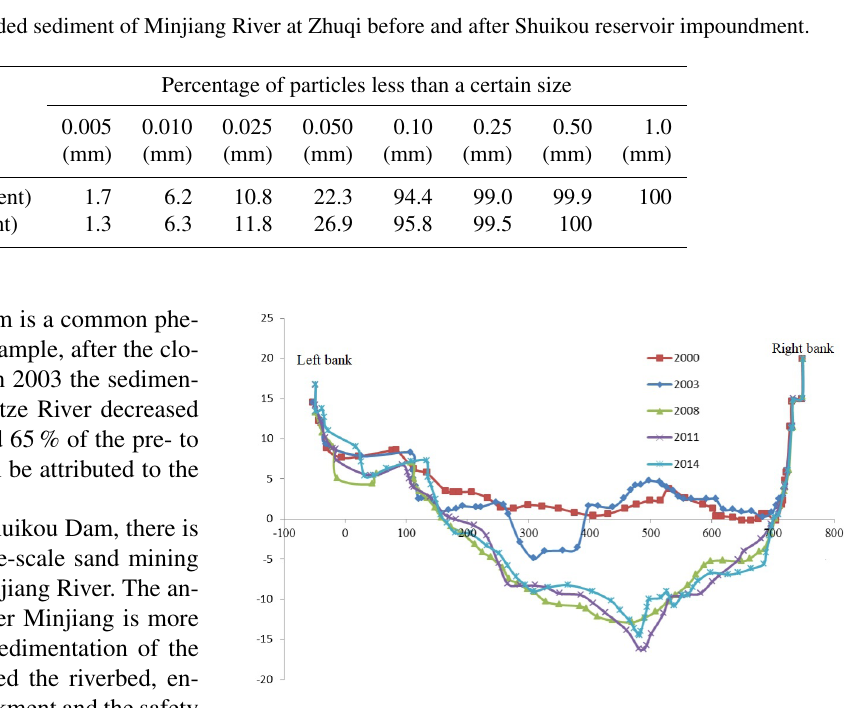
Figure 4. River bed elevation at the cross-section (from the left bank to the right bank) of the Minjiang River at Zhuqi in different